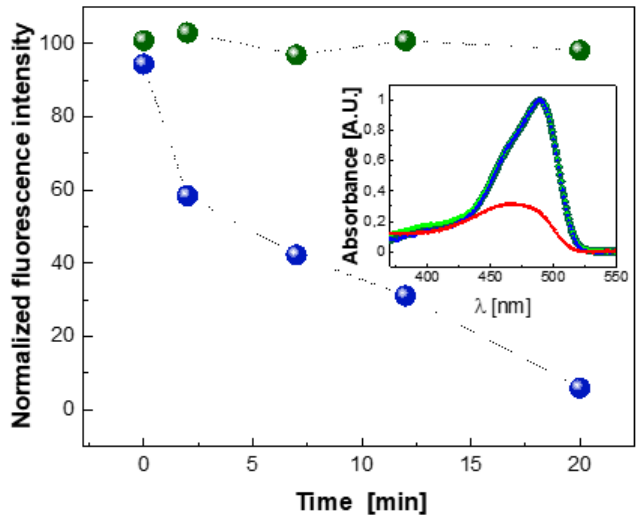
Figure 7 . ROS-induced photobleaching of the EGFP chromophore. For the purpose of exposure of EGFP to photosensitized ROS, a 10- µ M solution of EGFP in phosphate buffer (pH 8.0, 300 mM NaCl), also containing 100 μM MB and 50 mM TMP-OH (blue dots), was prepared. Such a solution and its control version (without MB and TMP-OH, green dots) were exposed to visible light during consecutive time periods of 0, 2, 7, 12, and 20 min. For the fluorescence measurement at λ em = 510 nm ( λ exc = 489 nm), the withdrawn samples were additionally diluted to obtain the final concentration of 0.5 μM EGFP. Inset: Control absorption spectra collected for EGFP in the absence of MB and TMP-OH before (dark green trace) and after (light green trace) the exposure for 20 min to visible light; absorption spectra collected for EGFP in the presence of MB and TMP-OH before (blue trace) and after (red trace) the exposure to visible light for 20 min. The overlapping of dark green, light green, and blue lines shows that the chromophore is not bleached.